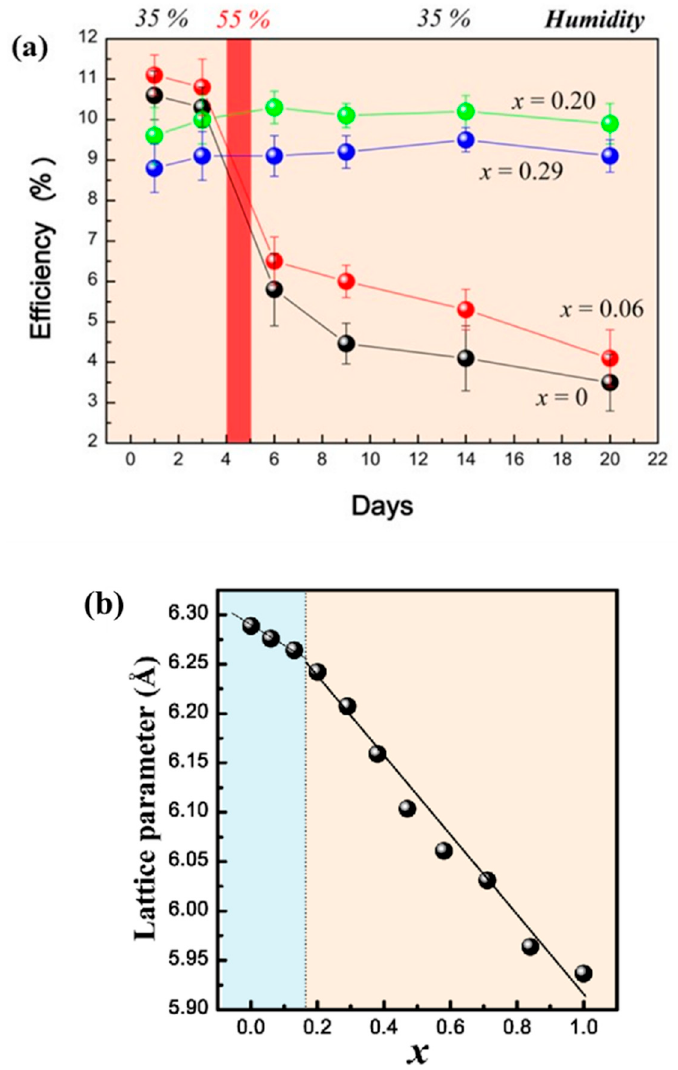
Figure 4. ( a ) Power conversion efficiency of the MAPb(I 1 − x Br x ) 3 (x = 0, 0.06, 0.20, and 0.29)-based solar cells measured in the air (at room temperature) without encapsulation; and ( b ) the lattice parameters of pseudo cubic or cubic MAPb(I 1 − x Br x ) 3 as a function of Br composition (x). Reprinted with permission from Ref. [157]. Copyright: American Chemical Society 2013.